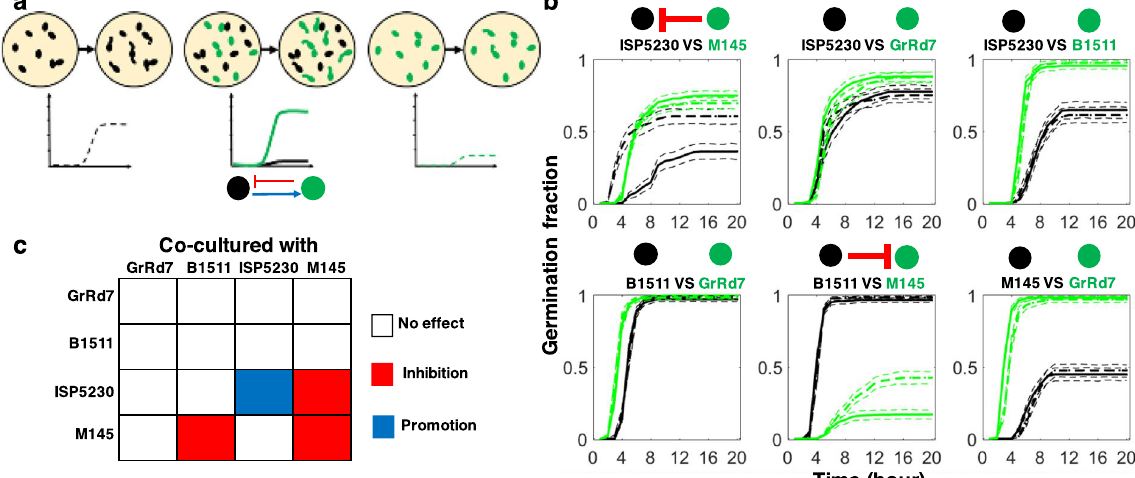
Figure 6. Germination interactions in two-species communities. ( a ) Schematic of the experiment. Red fluorescent spores (shown in black) and green fluorescent spores (shown in green) from different strains are grown by themselves (dashed germination curves) or together (solid germination curves). ( b ) The results from the six 1:1 co-cultures of two different strains are shown along with the inferred interactions. The 95% confidence intervals are indicated as thin dashed lines. All sample sizes are above 200 spores. ISP5230 is inhibited by M145 ( p < 10 − 26 ). M145 is inhibited by B1511 ( p < 10 − 15 ). ( c ) The matrix of germination interactions deduced through co-culture